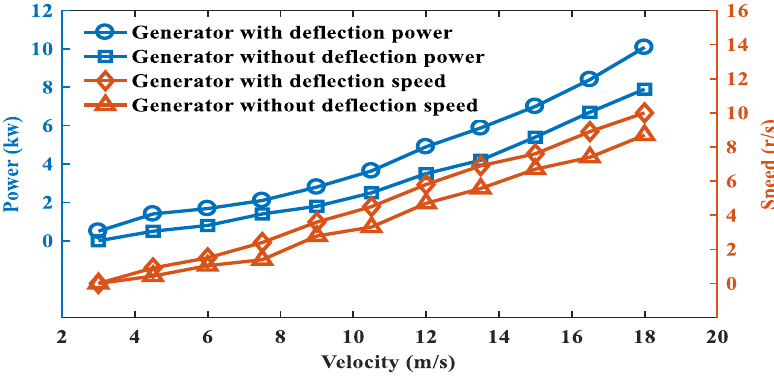
Figure 36. Comparison of power curves post deflection.